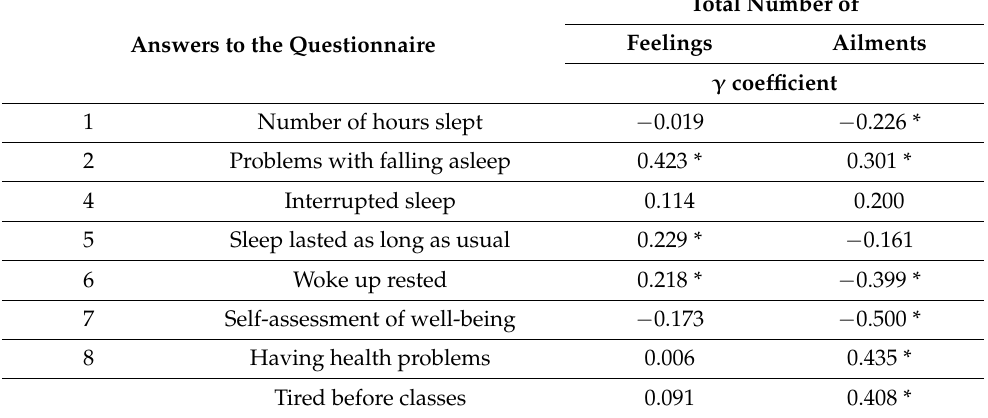
Table 3. Relationships between results of pre- and post-exposure questionnaires assessed using a gamma coefficient. Data concern all study subjects.